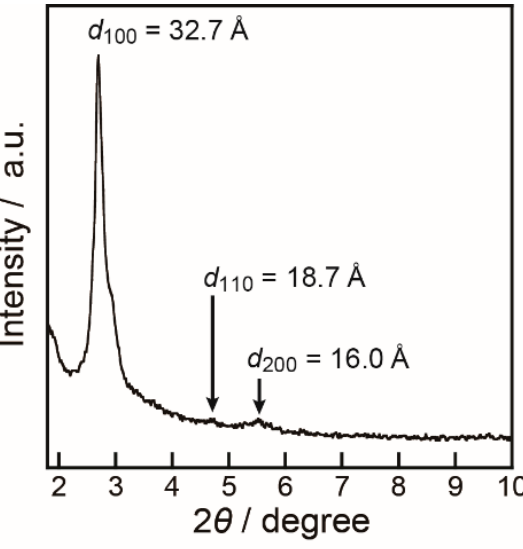
Figure 4. X-ray diffraction (XRD) pattern of pQpdS-Ch /H 2 O (X = 60) weight ratio at 30 °C. POM observation for macroscopically aligned samples is a useful strategy